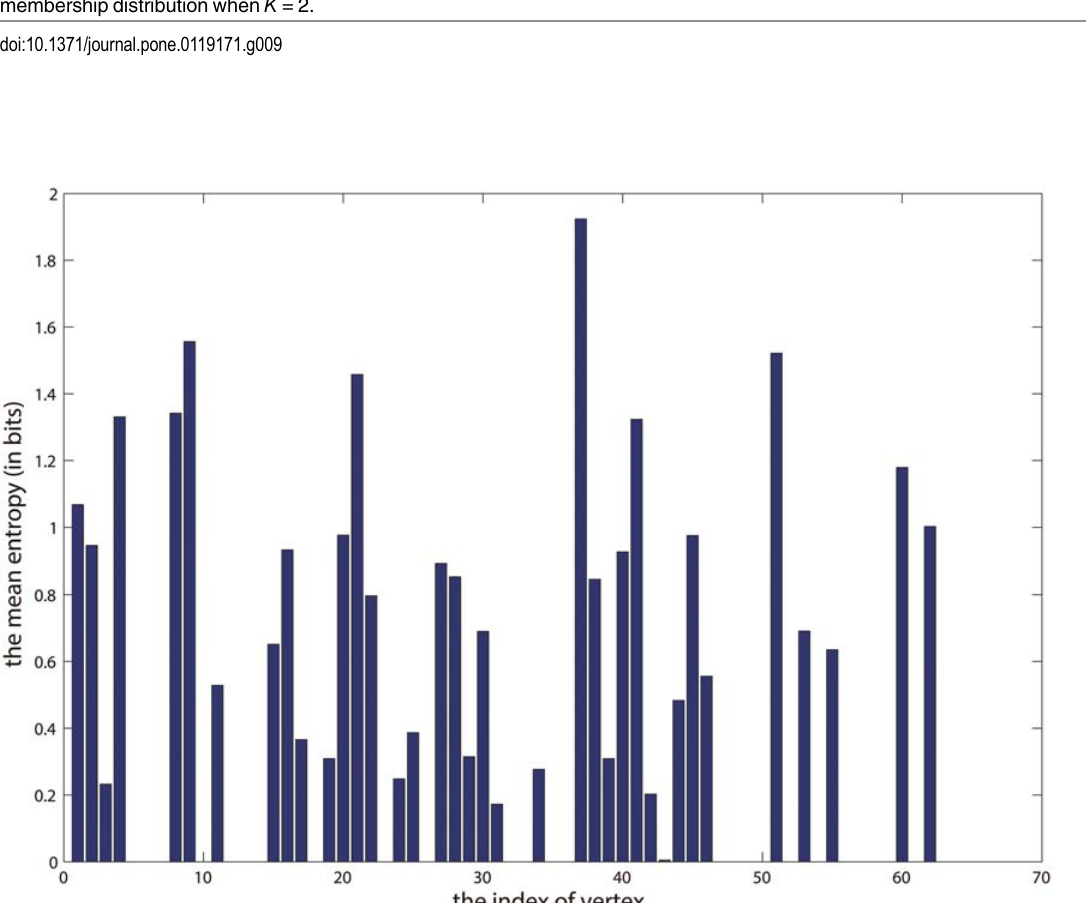
Fig 10. The mean entropy of membership distribution when K = 4. X-axis indicates the index of each vertex, and the Y-axis indicates the mean entropy of membership distribution when K = 4.